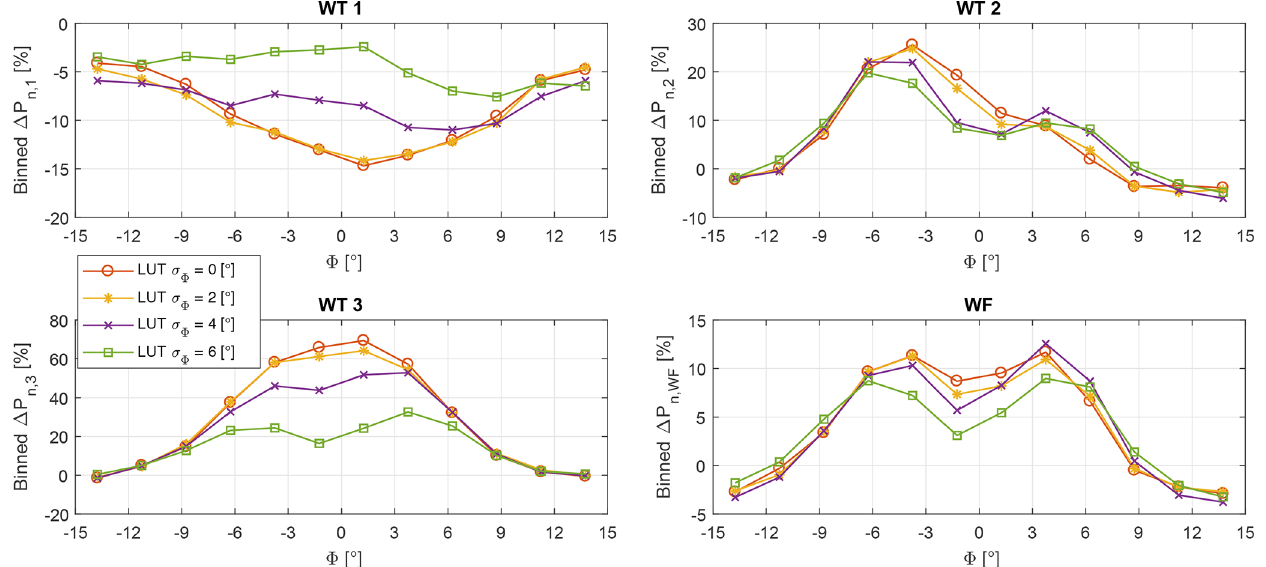
Figure 15. Power gains with respect to the greedy policy vs. wind direction, shown for the baseline FLORIS model and increasing robustness of the